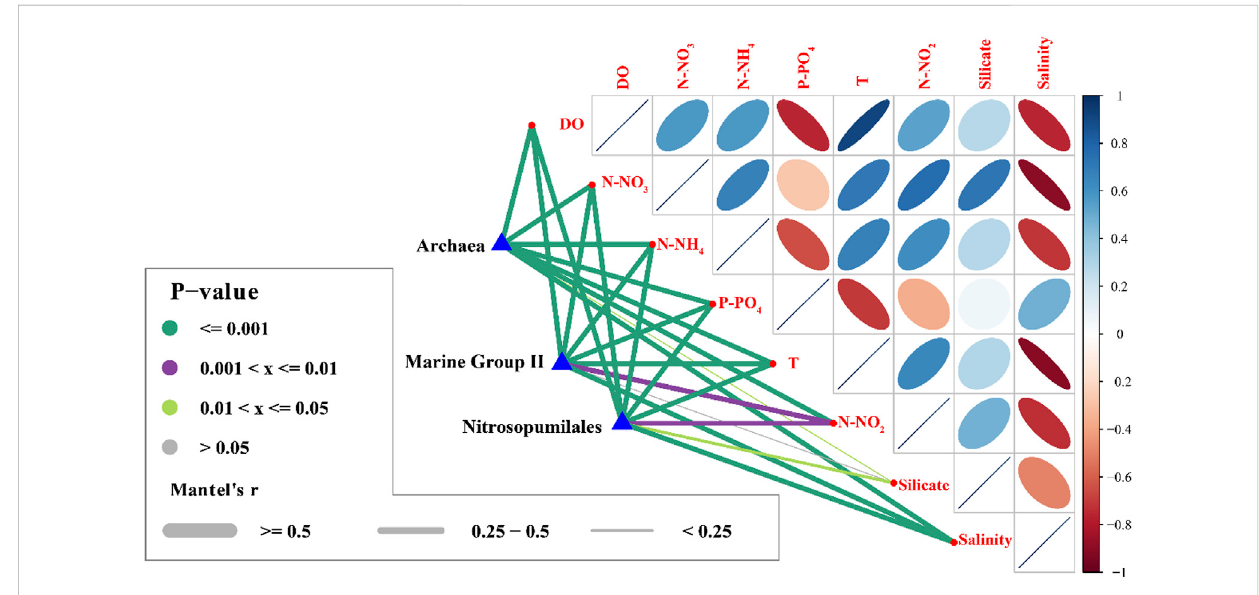
FIGURE 7 Mantel test showing the relationship between environmental factors and major